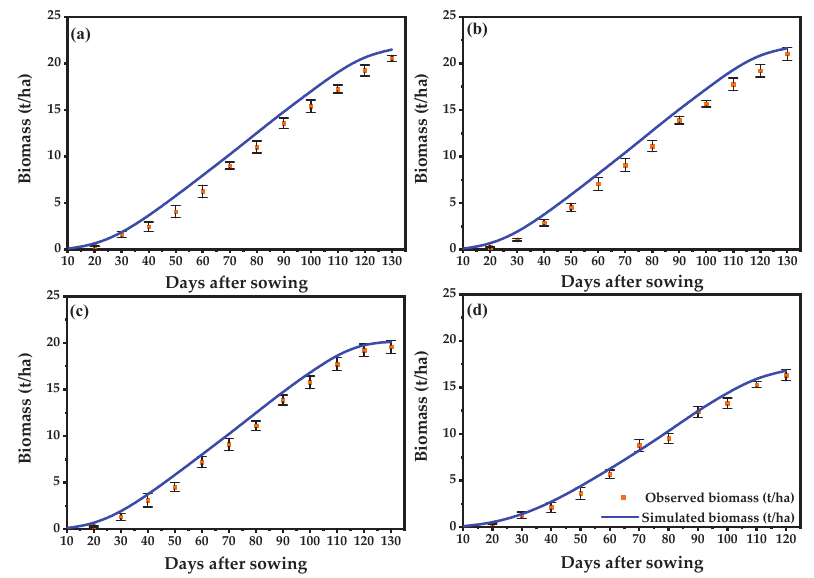
Figure 9. Observed and simulated average biomass during the validation period (2020) under four irrigation regimes. FI, flood irrigation ( a ); 3IF, 3-day irrigation frequency ( b ); 6IF, 6-day irrigation frequency ( c ); and 10IF, 10-day irrigation frequency ( d ). Error bars indicate standard deviation among the three replicates.